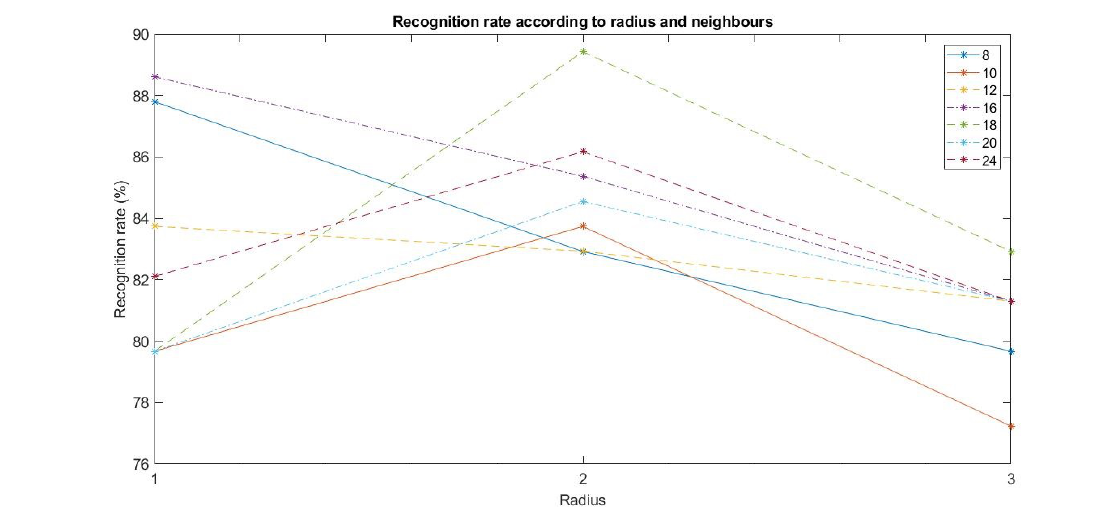
Figure 7. Recognition rate according to radius and